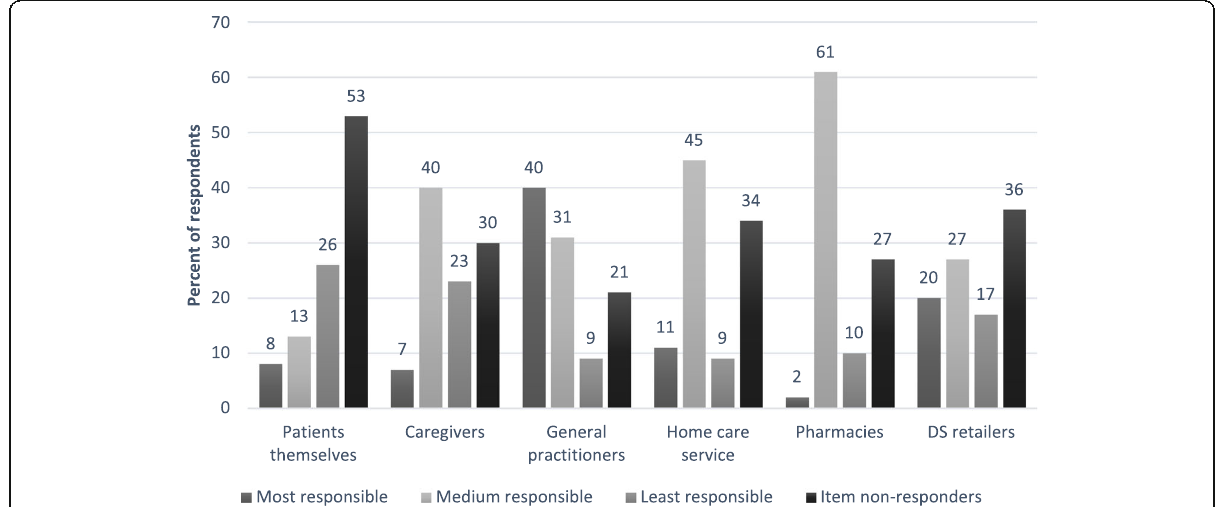
Fig. 2 The employees ’ ranking of responsibility for the safety of persons with dementia who use dietary supplements. The employees were given six options addressing the question “ Where should the responsibility for the safe use of DS by persons with dementia be placed? ”